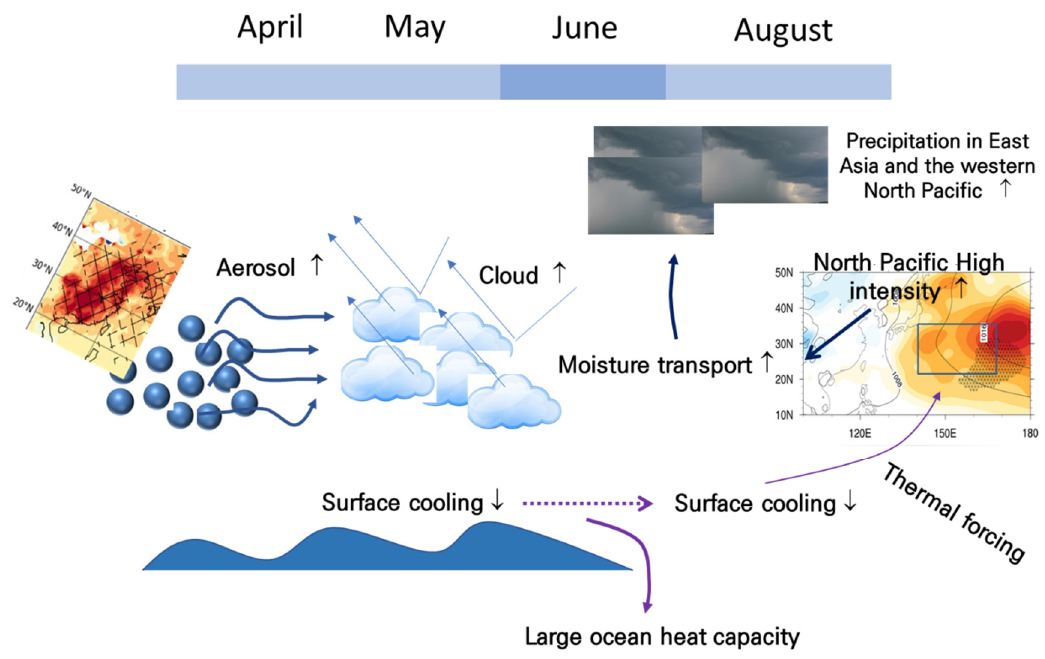
Figure 6. Schematic diagram showing the process through which AA variability in AMJ affects precipitation in JA.